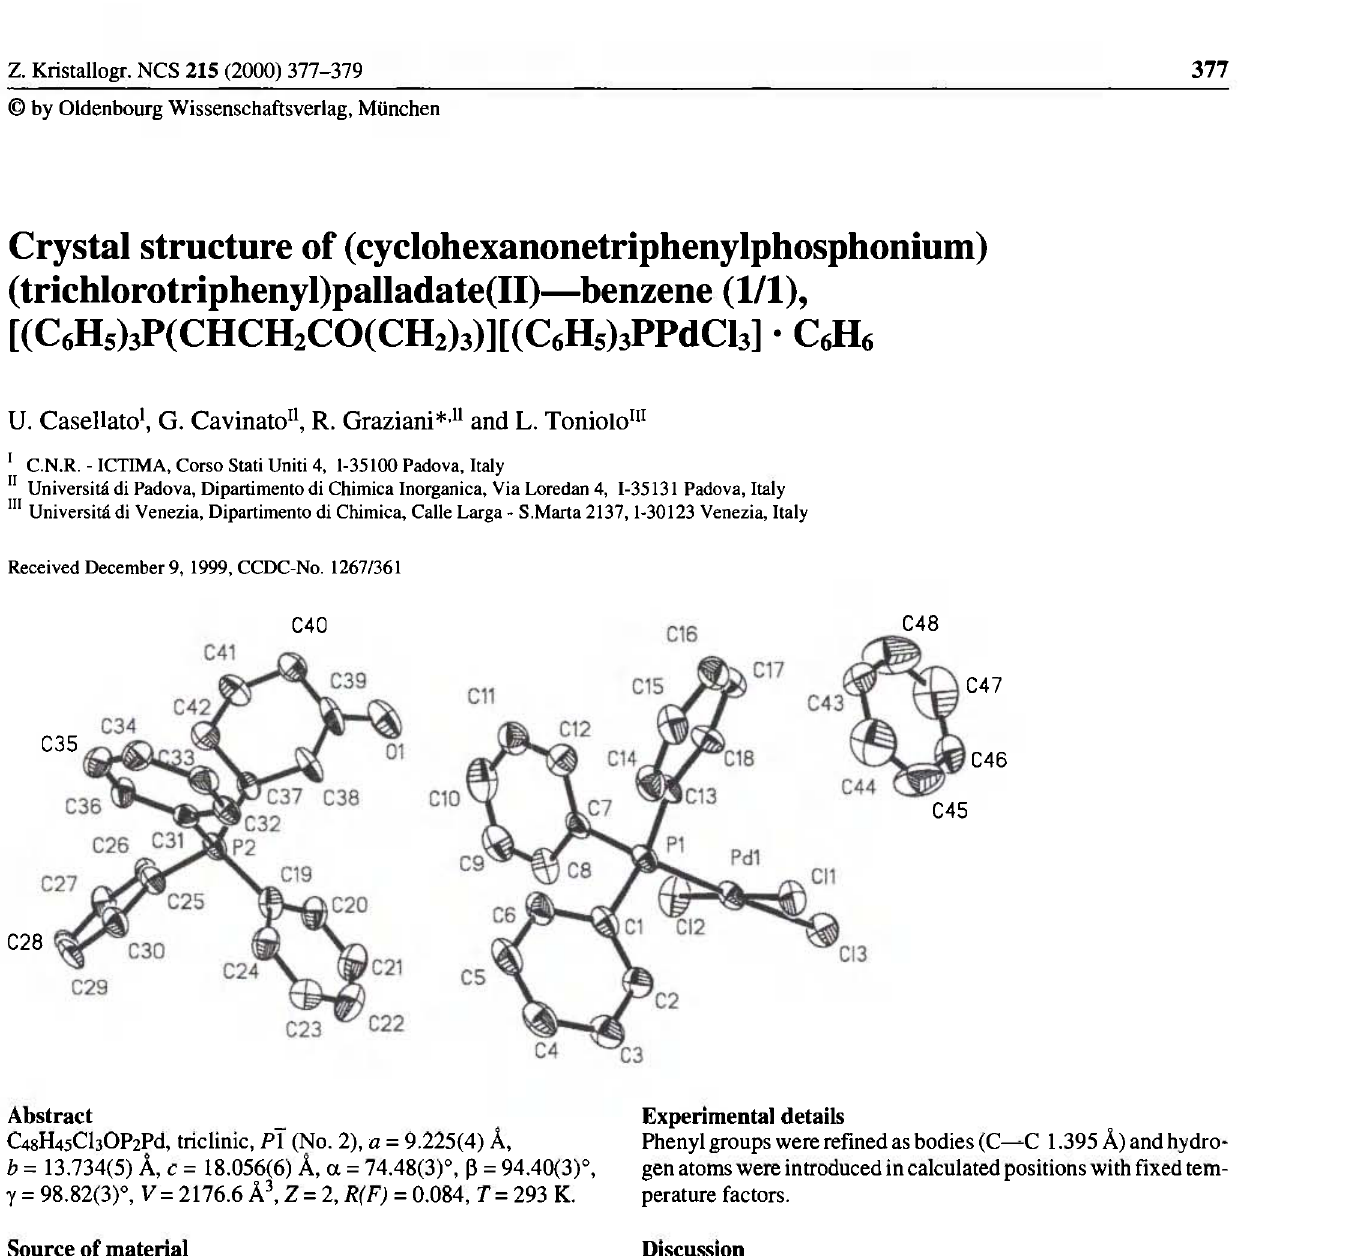
Table 1. Data collection and